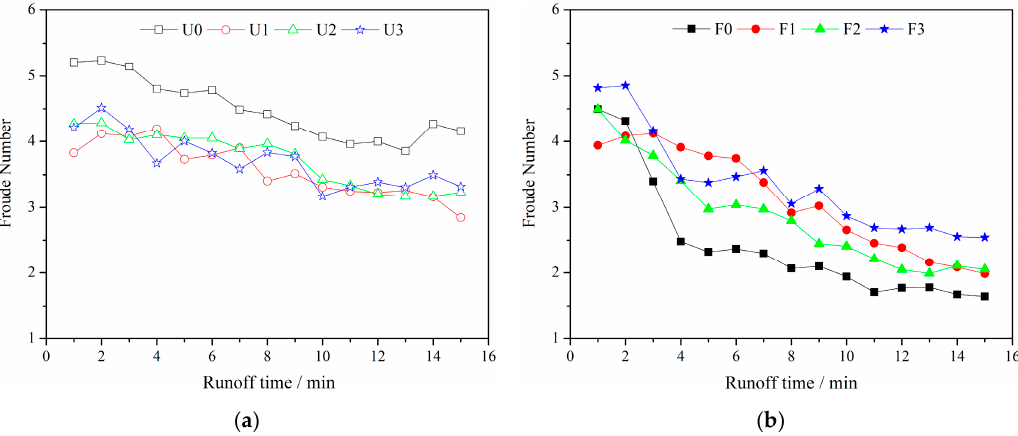
Figure 6. Variations in the Froude number under different treatments over time. ( a ) Unfrozen slope, ( b ) frozen slope.